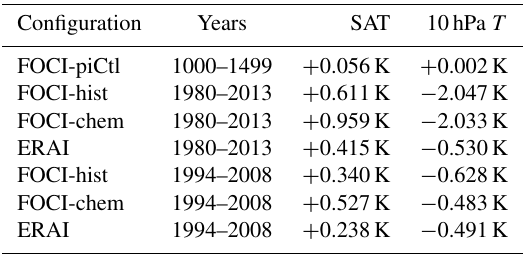
Table 3. Trends of SAT and 10hPa temperature in FOCI-piCtl as well as FOCI-hist and FOCI-chem ensemble means compared to ERA-Interim data for different time